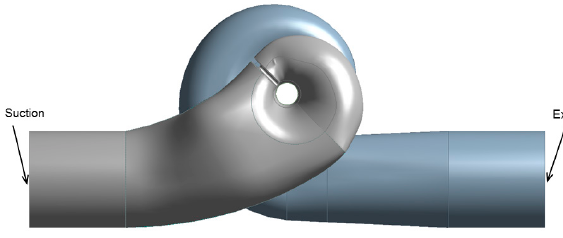
Figure 1. 3D geometry of inner fluid region of the pump. Table 1. Important design parameters of the pump studied in this work.